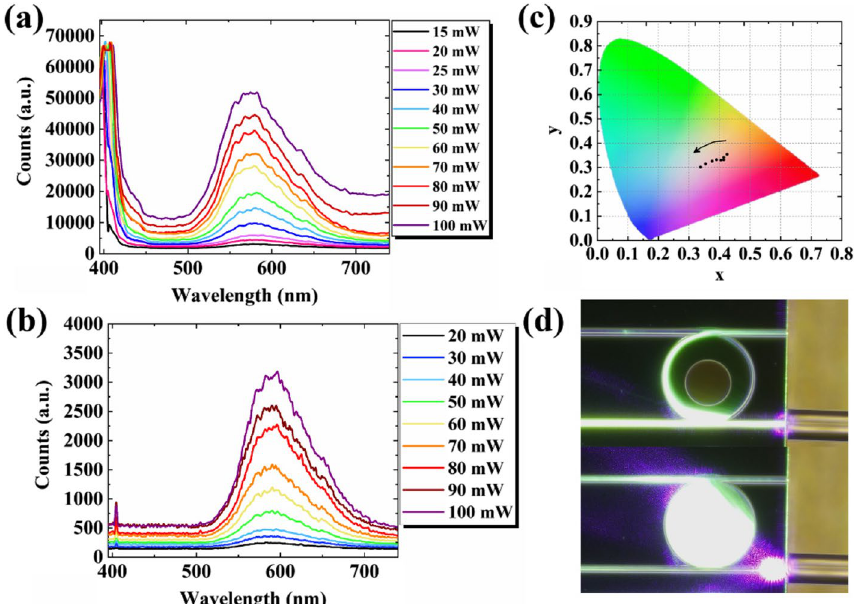
Fig. 11 The measurements for actual dual-microdisk waveguide. a Horizontal emission output spectra of the dual-microdisk waveguide; b vertical emission output spectra of the dual-microdisk waveguide; c the CIE chromaticity diagram coordinates of the spontaneous light; d the measuring images for actual dual-microdisk waveguide chip